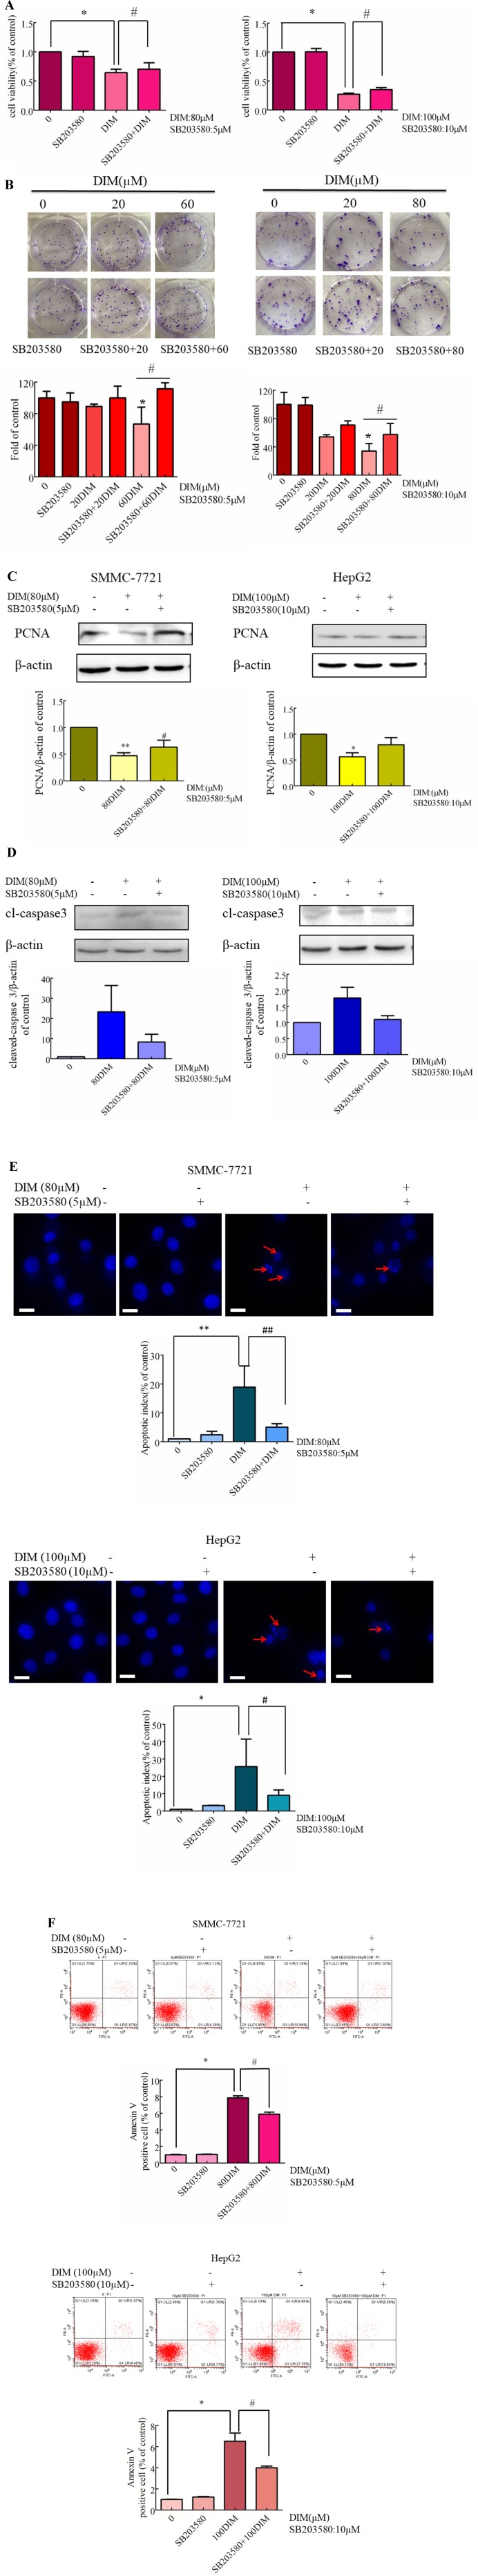
Effects of p38 MAPK inhibitor on DIM-induced apoptosis in hepatoma cancer cells. SB203580 was used 3 h prior to the addition of DIM for 24 h. (A) Effects of SB203580 on DIM-induced proliferation inhibition assessed by CCK-8 assay. (B) Effects of SB203580 on DIM-induced cell proliferation inhibition assessed by clonogenic formation assay. (C) Effects of SB203580 on DIM-induced PCNA protein expression. (D) Effects of SB203580 on DIM-induced changes of cleaved caspase-3. β-actin was used as an internal control. (E) Effects of SB203580 on DIM-induced apoptosis determined by Hoechst staining. (F) Effects of SB203580 on DIM-induced apoptosis determined by Annexin V-FITC/PI staining and flow cytometry. Scale bar represents 15 µM. Data represent mean ± SD of three independent experiments (n = 3). *P < 0.05, **P < 0.01 compared with controls; #
P < 0.05, ##
P < 0.01 compared with DIM alone group.